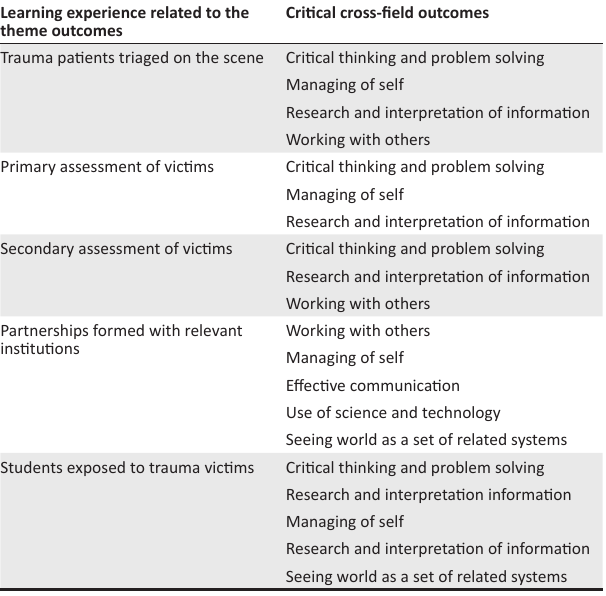
TABLE 3: Critical cross-field outcomes align with learning experience of the mass casualty